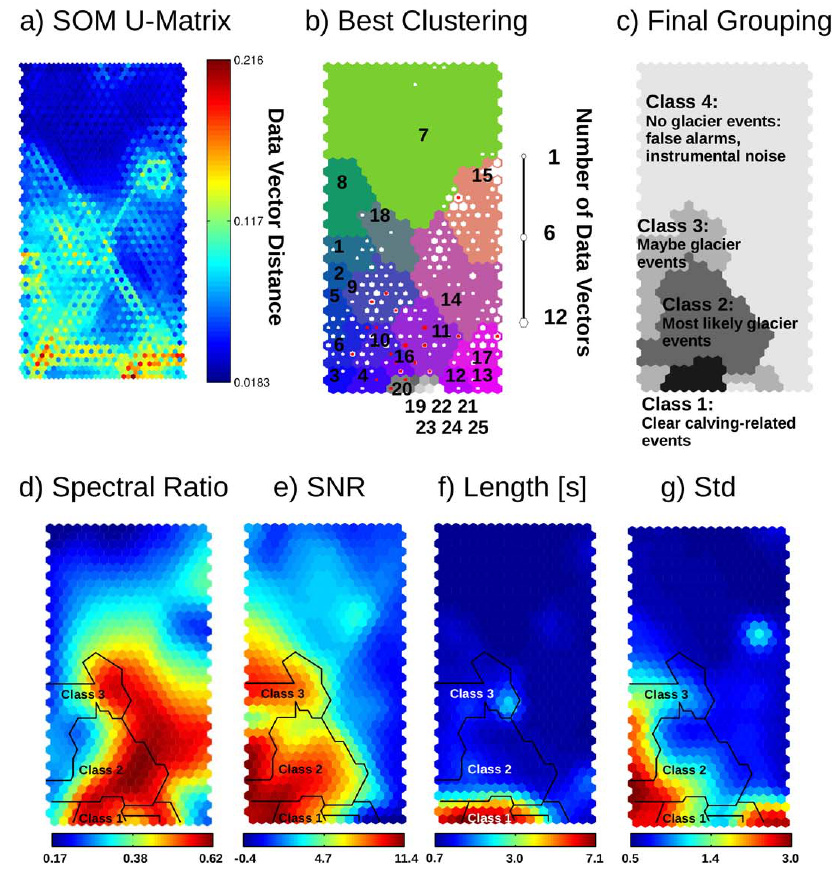
Fig. 3. SOM and clustering of detected seismic events. (a) Unified distance matrix (U-matrix) which reveals data density in input space. Each SOM unit is divided into seven sub-unit. Each sub-unit is colored according to distance between corresponding data vectors of neighbor units. Areas with low distances (blue) indicate high data density (i.e. clusters). (b) Cluster solution chosen based on U-matrix and DB index (see text). Cluster membership of each SOM unit is indicated by color. Clusters with a grey scale fill are those which are obtained by splitting clusters from one solution with 18 clusters. Symbols show data projected on SOM. Sizes of hexagons correspond to number of projected data vectors represented by a SOM unit. White symbols correspond to detections within 11 days long period where direct observations of glacier front are available (matched and unmatched). Red symbols are detections matching with events observed in Zone 1. (c) Final grouping of events based on matching rates and inspection of examples from each cluster. (d–g) Component planes for four selected features: Ratio between mean spectral amplitudes, signal to noise ratio, length of a detections, and standard deviation of signal envelope. Each SOM unit is colored according to value of a particular data vector component. Red colors stand for high values of corresponding feature. Outline of signal classes is